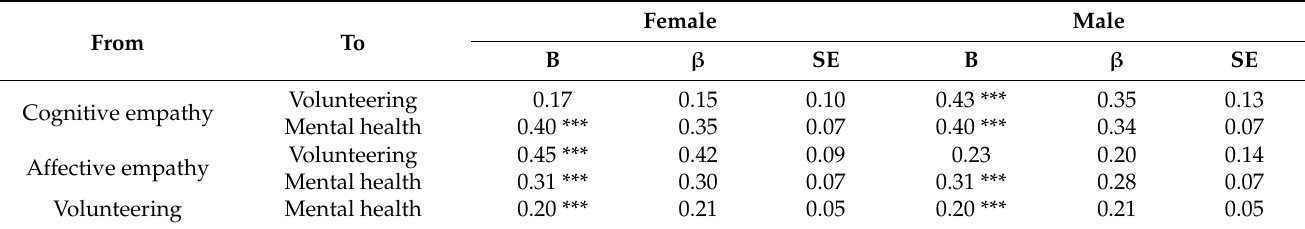
Figure 1. Results from the constrained model. Note: Standardized path coefficients are presented in parentheses. *** p < 0.001. Estimates from M3, a model with 2 released paths (from cognitive empathy to volun- teering, and affective empathy to volunteering, respectively) are illustrated in Table 4 and Figure 2. Table 4. Coefficients from group analysis by